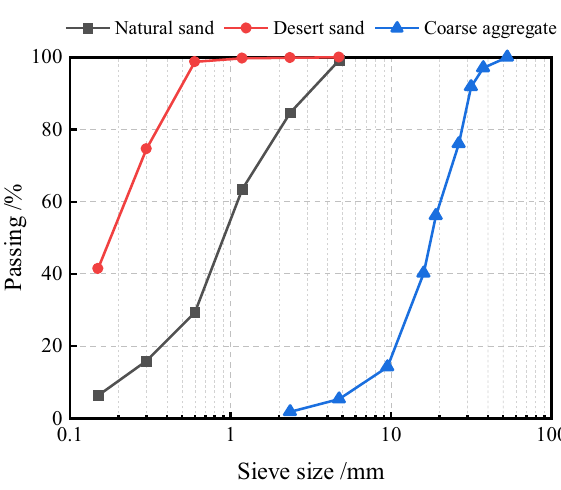
Figure 1. Particle distribution of coarse and fine aggregate.